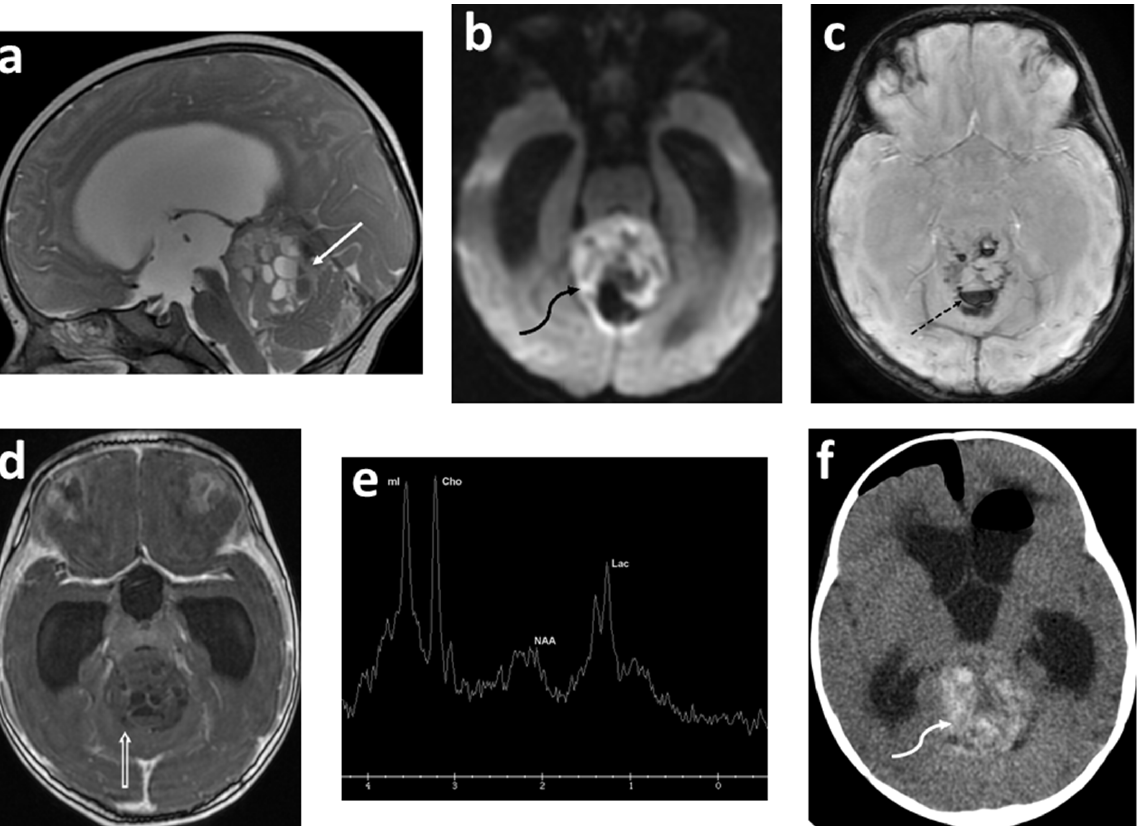
Figure 3. Five-month-old referred for increased head circumference. Sagittal T2 ( a ); axial DWI ( b ); axial SWAN ( c ); axial T1 IR (inversion recovery) post contrast ( d ); short TE 35 millisecond spectroscopy ( e ); and axial non-contrast enhanced CT ( f ) post ventricular shunt placement. There is a large heterogeneous solid ill-defined mass lesion involving the superior and anterior aspect of the vermis (solid white arrow) effacing the fourth ventricle. There are multiple cystic areas within the lesion demonstrating fluid/fluid levels. There is restricted diffusion (curved black arrow) and hemorrhage (dashed arrow). No significant enhancement is identified (open arrow). Spectroscopy demonstrates very high myoinositol (mI), high choline (Cho) and decreased N-acetylaspartate (NAA). There is also elevation of lactate (Lac). CT scan shows high density within the lesion, indicating acute hemorrhage within the lesion (curved white arrow). Pathology confirmed an atypical teratoid rhabdoid